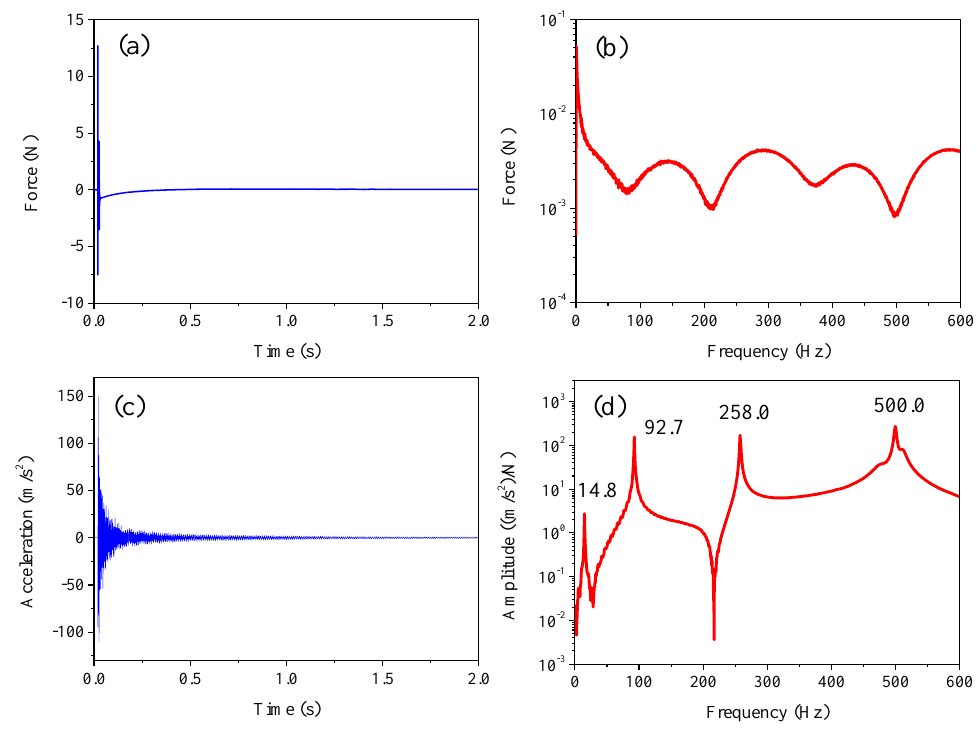
Figure 3. Signals of impacting force and acceleration. ( a ) impacting force; ( b ) frequency spectrum of impacting force; ( c ) acceleration; ( d ) acceleration FRF.